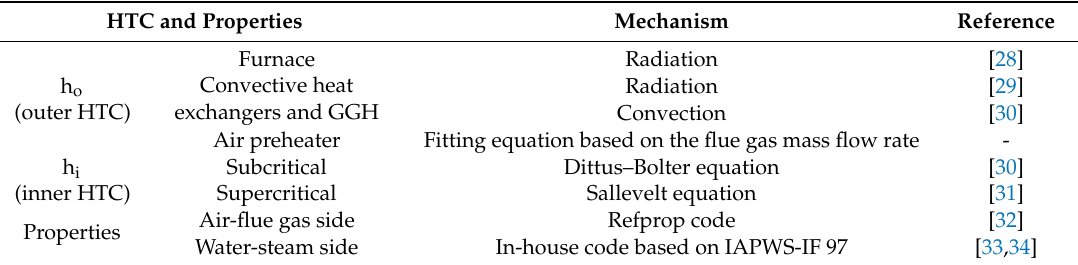
Table 4. Calculation methods for the heat transfer mechanism and